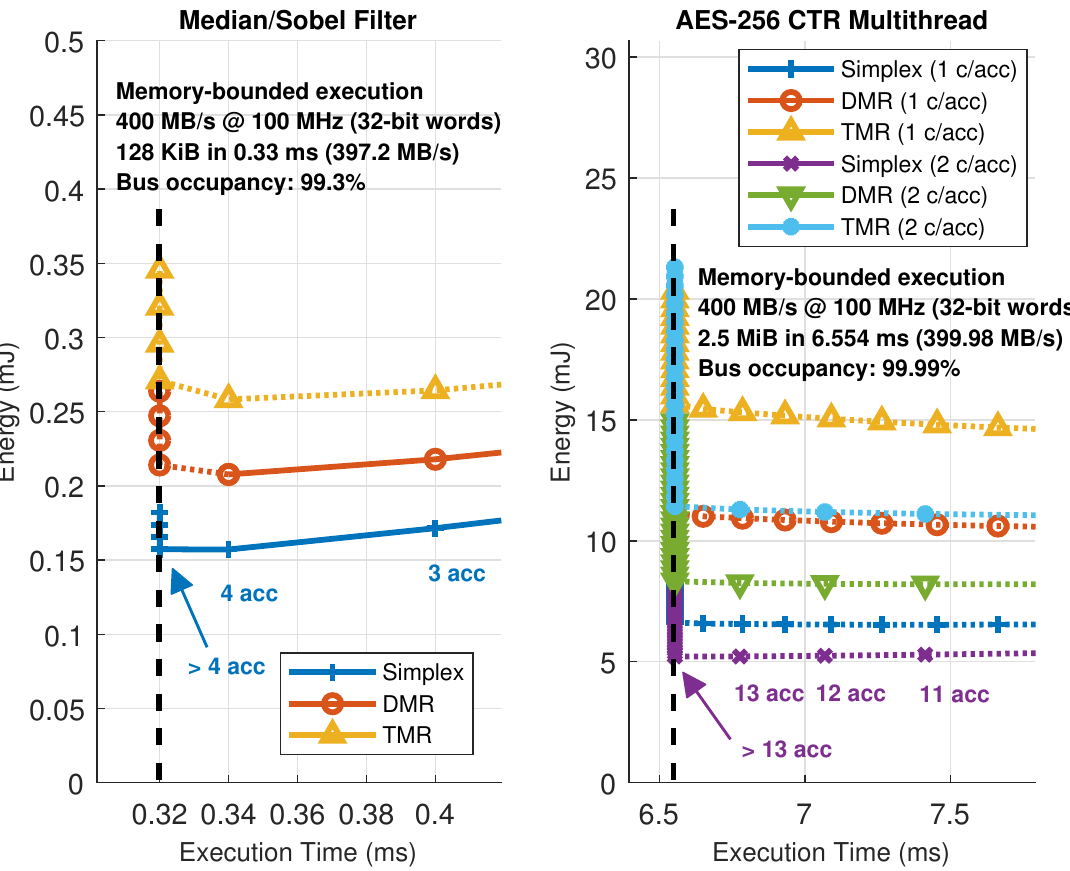
Figure 14. Closeup from the solution space exploration near the bus saturation point (memory-bounded behavior). behavior).